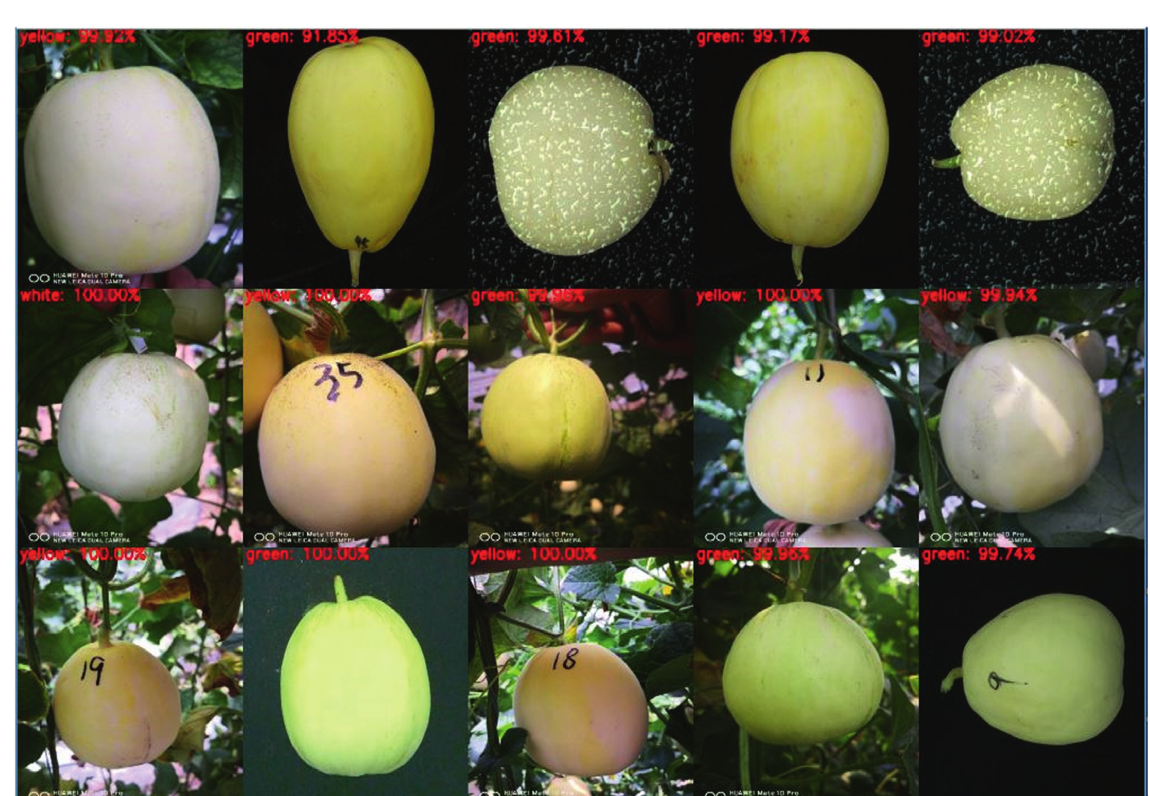
Figure 11: Visualization results of the tested model created from All dataset with code